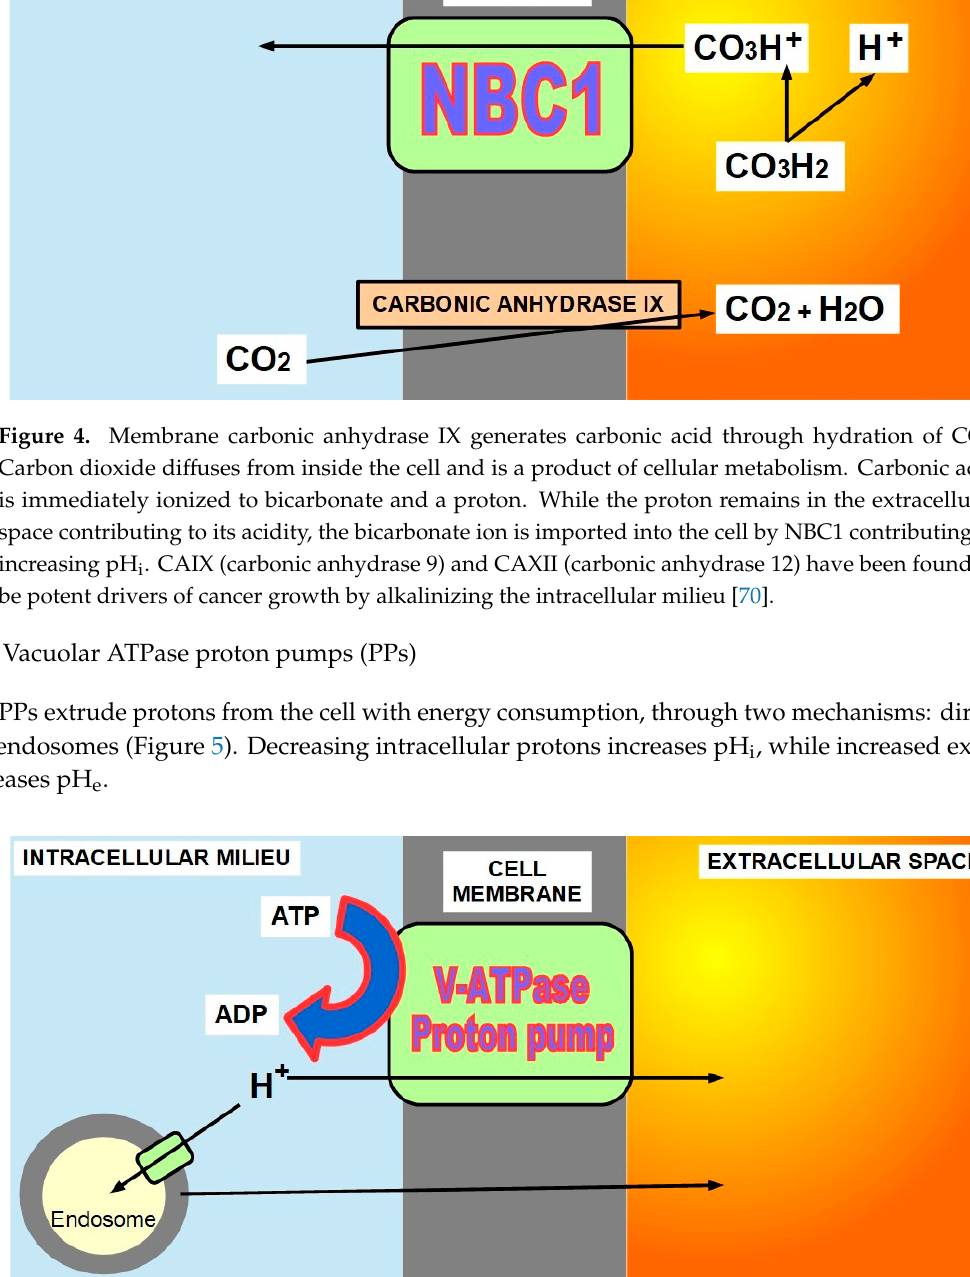
Figure 5. V-ATPase proton pump mechanism of action.